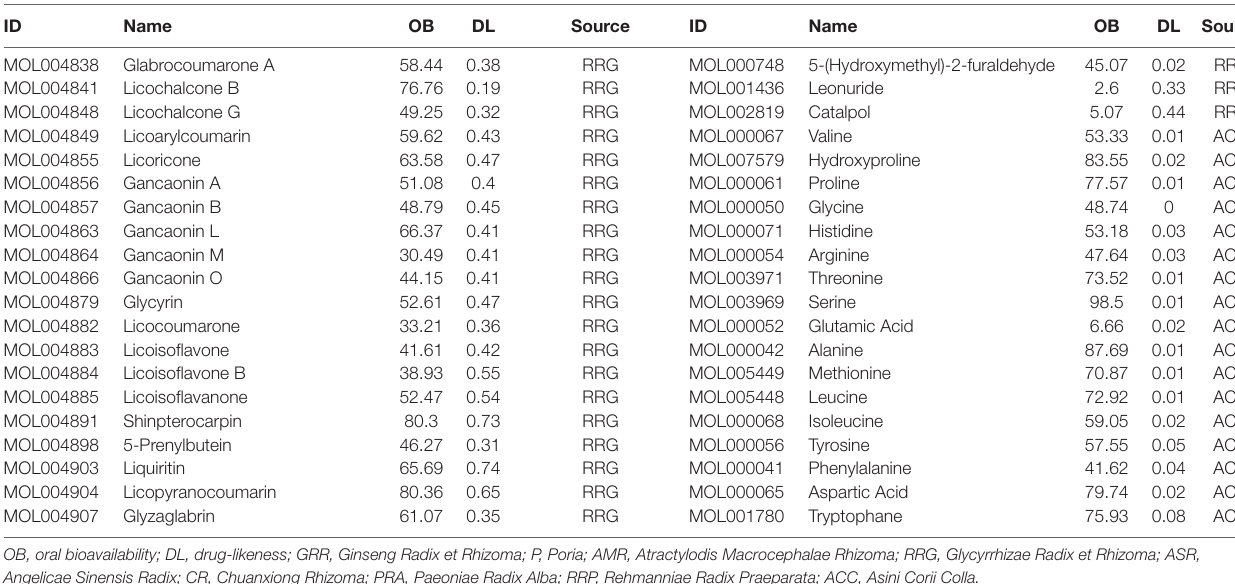
The PPI network of YQSX putative targets contained 5,959 nodes and 148,332 interactions. The PPI network of ITP-related targets contained 5,163 nodes and 127,564 edges.